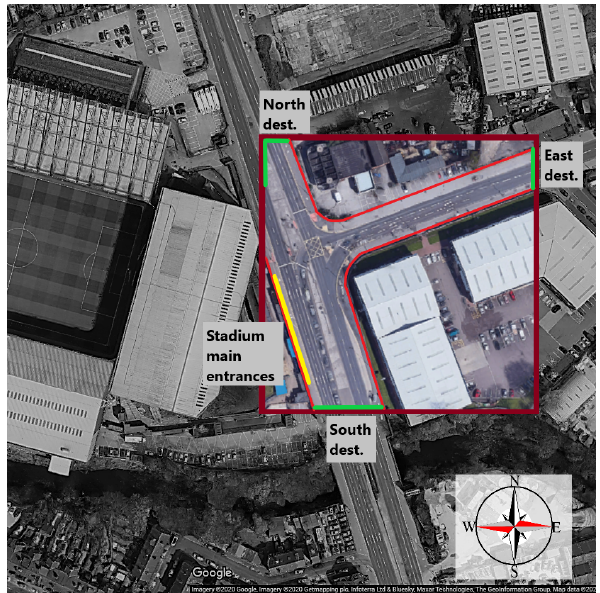
Figure 7. The study site (red square) including the walkable area (red area within the red square) people normally use to go to their different destinations located on the south, east, and north sides of the walkable area (green lines) after they leave the stadium from the main entrances (yellow line), ©